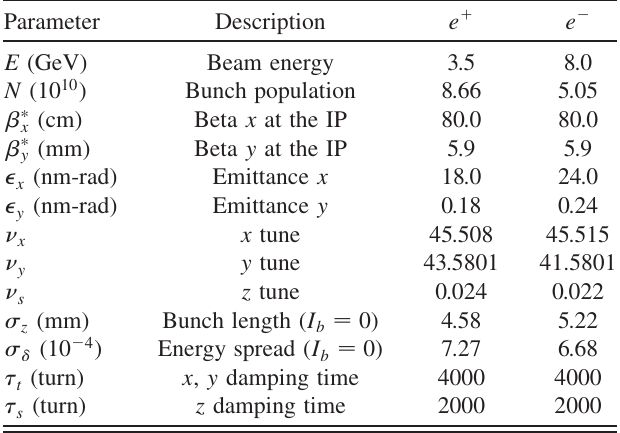
TABLE III. The main parameters of KEKB. The ring circum-